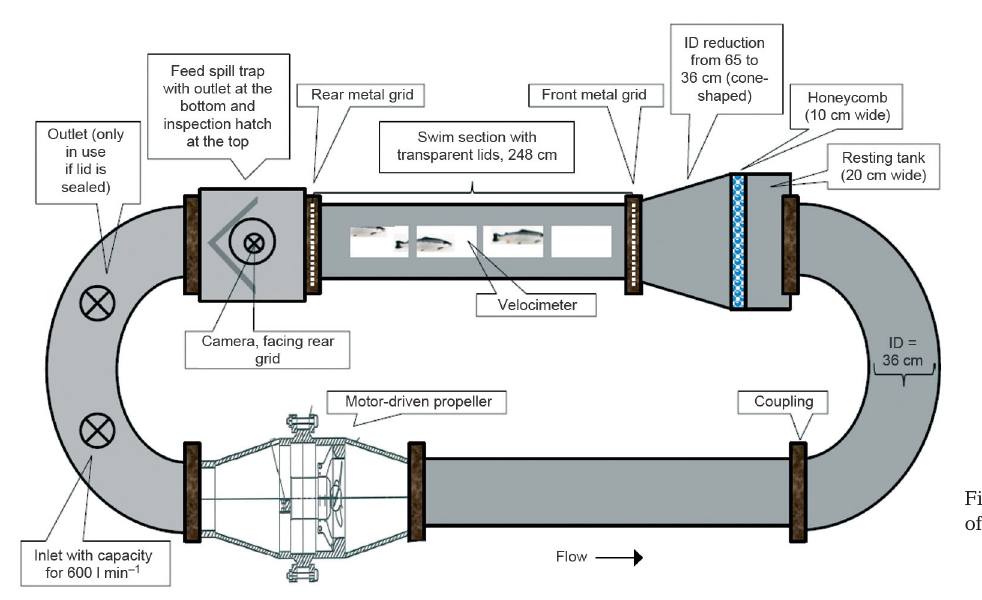
Fig. 1. Conceptual drawing of the large swim tunnel. ID: inner